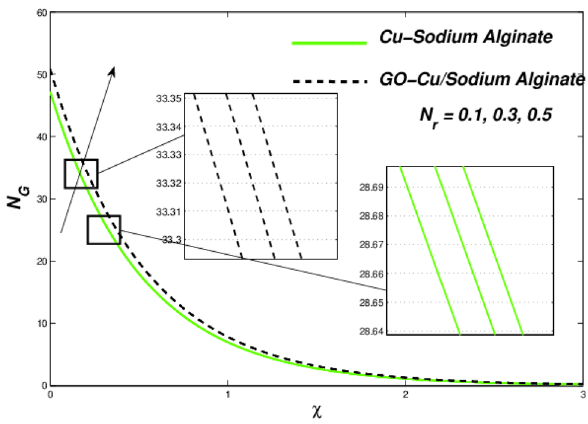
Figure 7. Variation in entropy regarding N r .